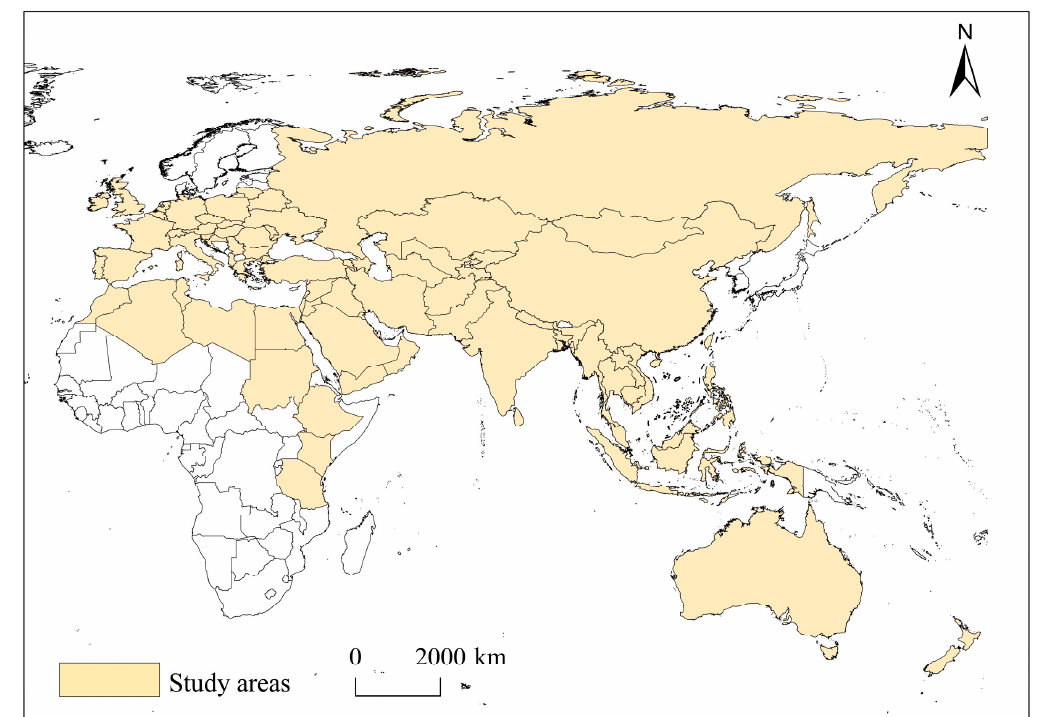
Figure 1. Study areas. Note: the map is drawn to the standard map of GS (2016) 1667 that come from the standard map service system of the ministry of natural resources of the people’s Republic of China (http://bzdt.ch.mnr.gov.cn/index.html, accessed on 8 December 2022).